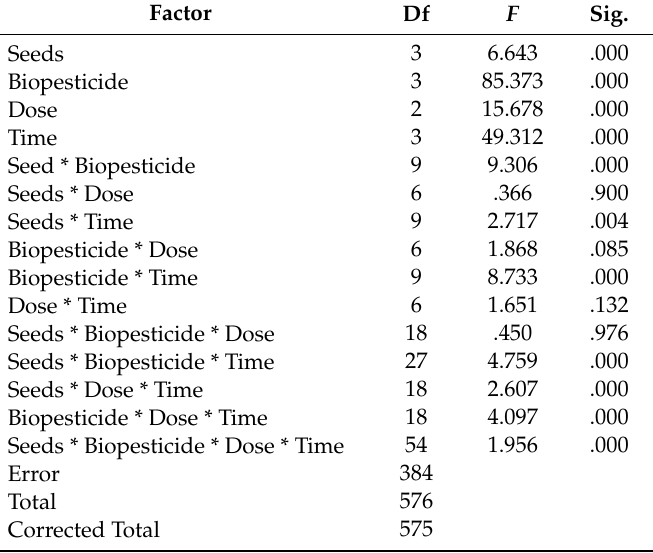
Table 5. ANOVA parameters for mortality levels of T. confusum adults exposed for 28 days to three doses of Metab, Lecan, and Zeolite that had been applied to hull and no hull seeds of A. sativa and L. usitatissimum.